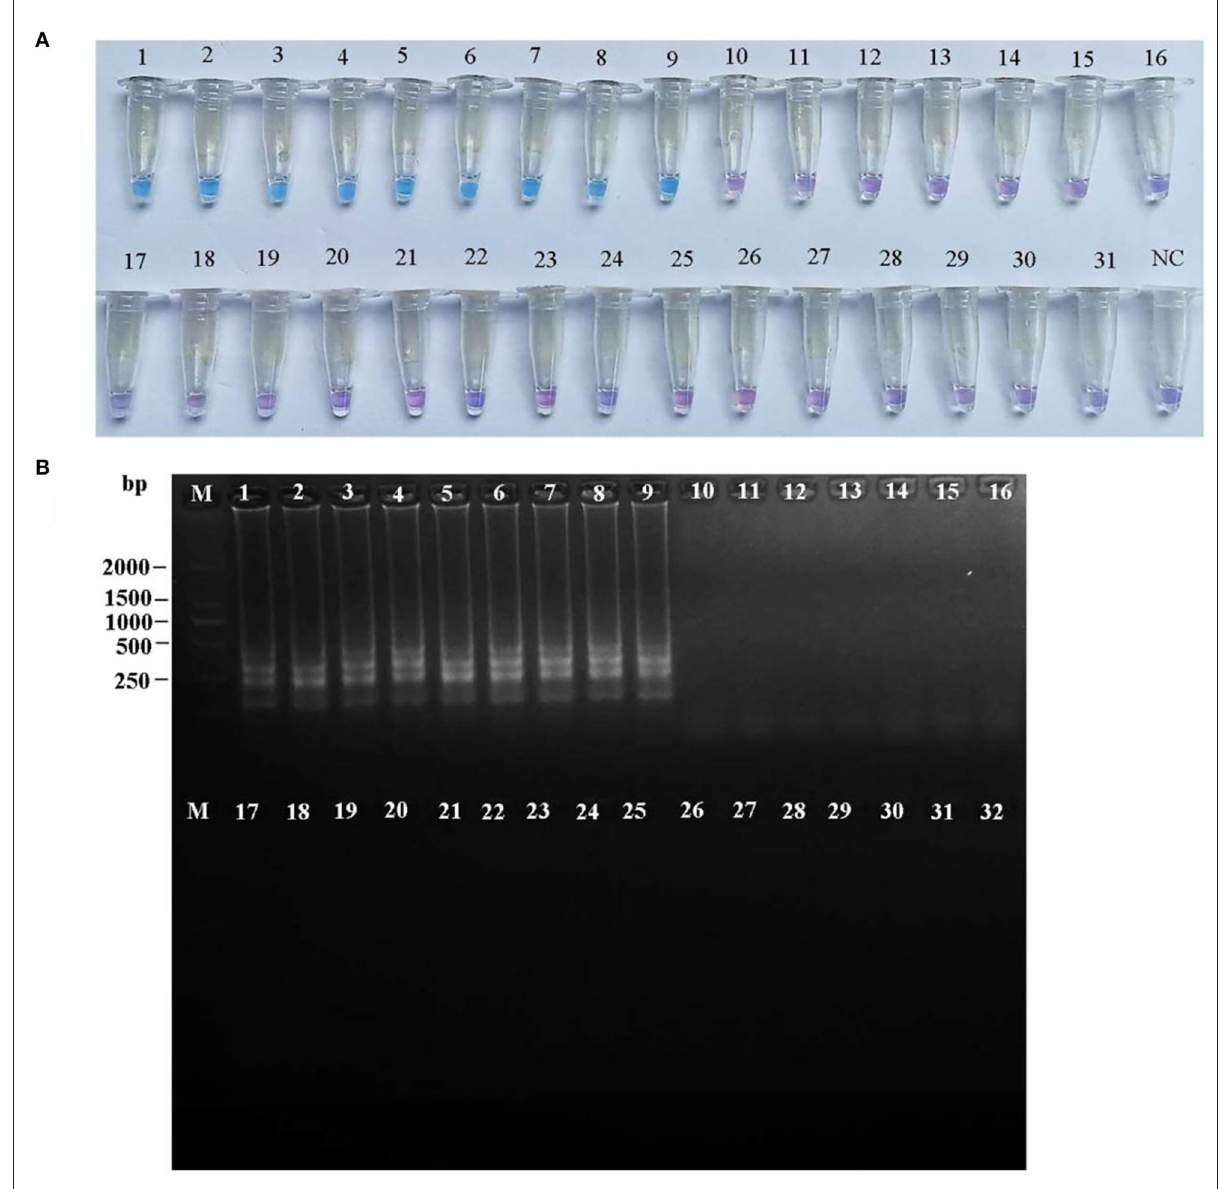
FIGURE6 Specificity of the LAMP assay for R. subnigricans . Hydroxy naphthol blue (HNB) dye staining of LAMP products (A) and agarose gel electrophoresis of LAMP products (B) . M: 100 bp ladder; lanes 1–9: R. subnigricans ; lanes 10–13: R. nigricans ; lane 14: R. densifolia ; lanes 15–16: R. crustosa ; lane 17: R. mairei ; lane 18: R. pulchra ; lane 19: R. chiui ; lane 20: R. risigallina ; lane 21: R. virescens ; lane 22: R. zvarae ; lane 23: R. griseocarnosa ; lane 24: R. senecis ; lane 25: R. sp.; lane 26: R. rosea ; lane 27: L. kesiyae ; lane 28: R. japonica ; lane 29: R. japonica ; lane 30: L. vividus ; lane 31: R. cyanoxantha ; and lane 32: ddH 2 O (blank control).